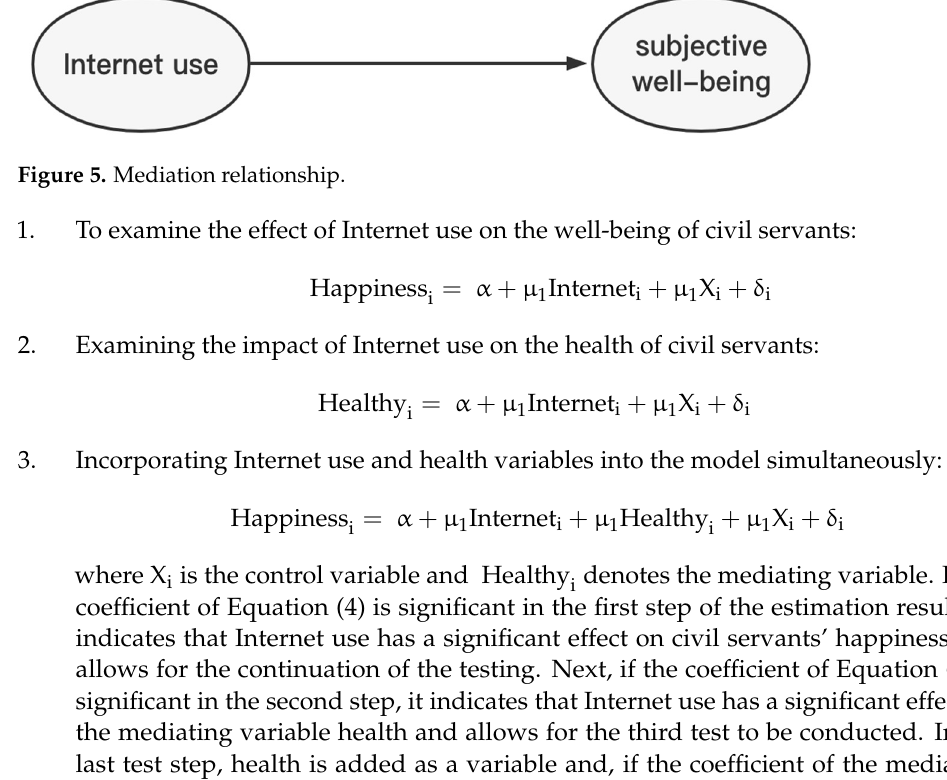
Table 8. Estimated results of mediating effects of self-rated